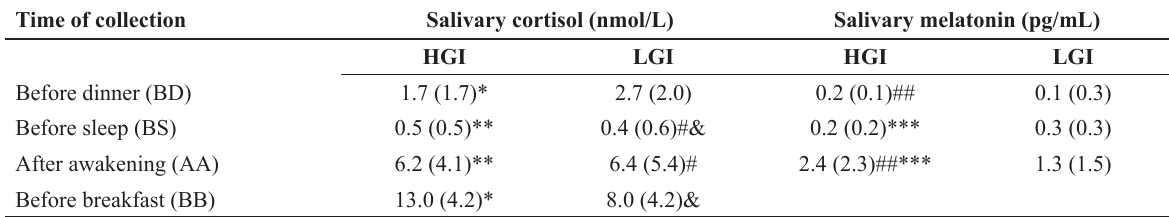
Median values of salivary cortisol and melatonin according to the time of collection and GI meals consumed. Time of